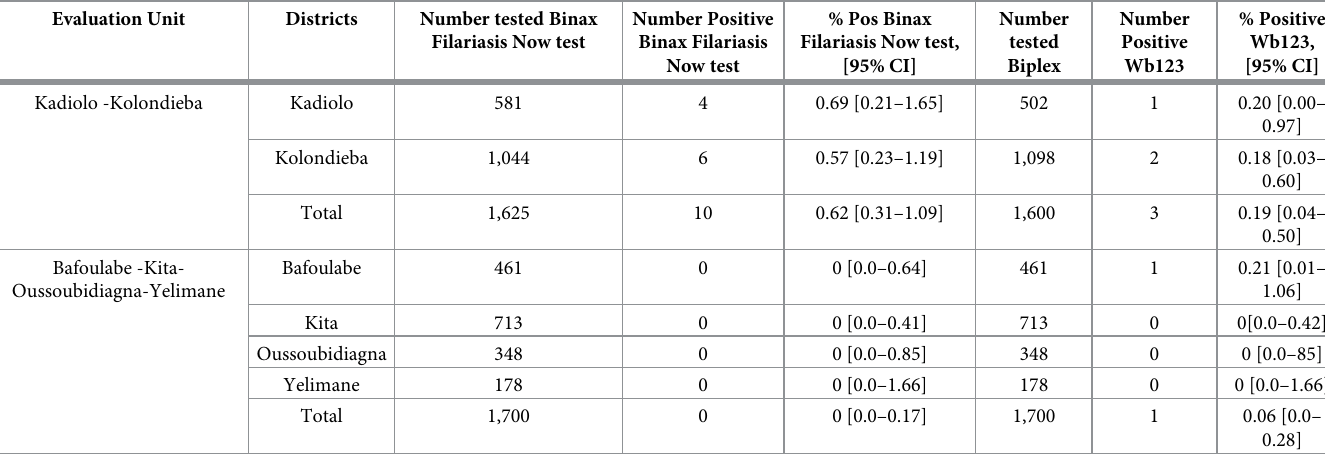
Table 4. Circulating filarial antigen and Wuchereria bancrofti seroprevalence per district and evaluation unit. Evaluation Unit